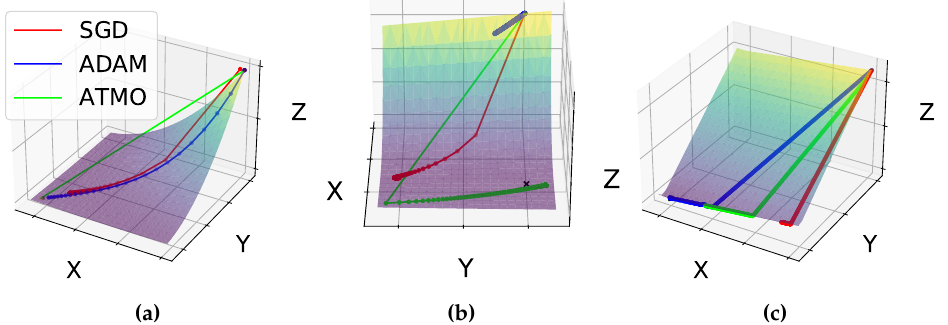
Figure 3. The figures show the behavior of the three optimizers ATMO, ADAM and SGD on different surfaces. The subfigure ( a ) describes the surface defined in Equation (27). For better visualization in this figure the SGD was shifted on X axis of 0.1. The subfigure ( b ) describes the Rosenbrook’s surface with a = 1 and b = 100. The subfigure ( c ) describes the surface z = | x |